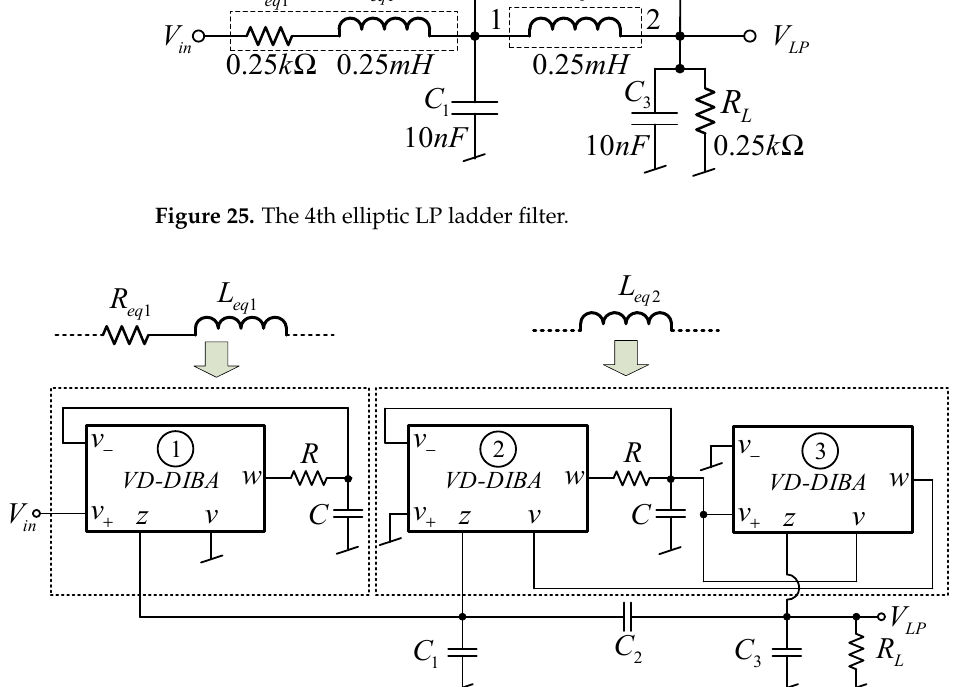
Figure 26. The completed 4th order elliptic LP ladder filter based on VD-DIBAs. The 4th order elliptic LP ladder filter was simulated by selecting C 1 = C 2 = C 3 = 1.04